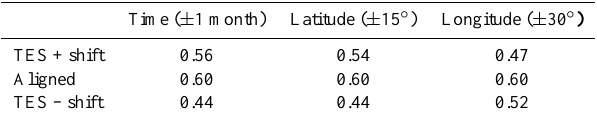
Table 4. TES correlation to GLOBALVIEW at and offset from GLOBALVIEW locations.